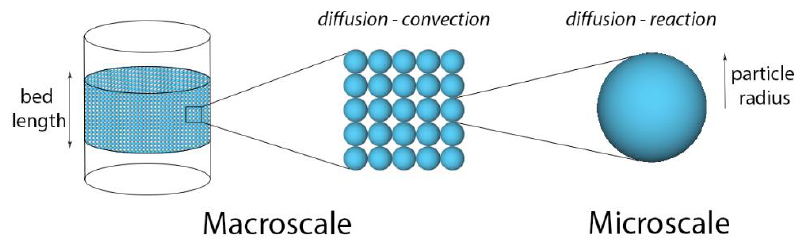
Figure 2. Multiscale model approach with macroscale (bed length) and microscale (particle radius) 1D dimensions.